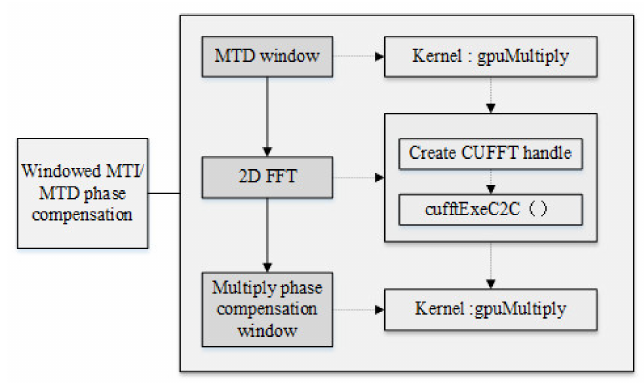
Figure 7. Windowed MTI/MTD phase compensation module